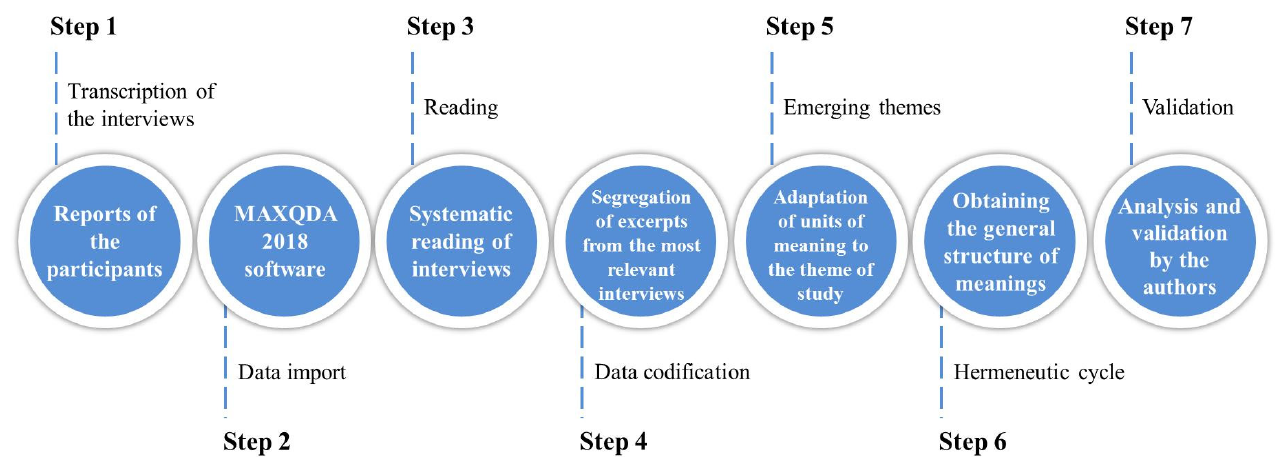
Figure 1. Description of the analytical process. Source: adapted from Smith et al. [106], elaborated by the authors.